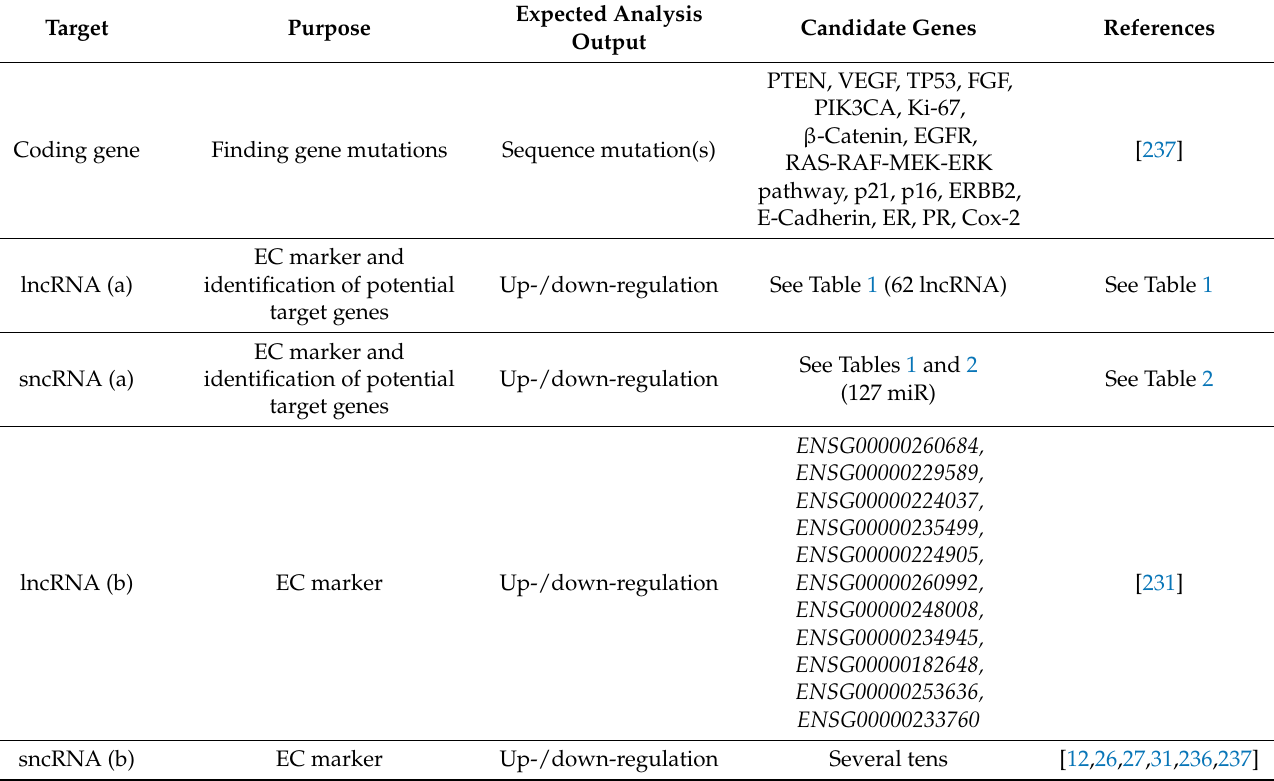
Table 4. Proposal for a diagnostic panel for highly parallel sequencing